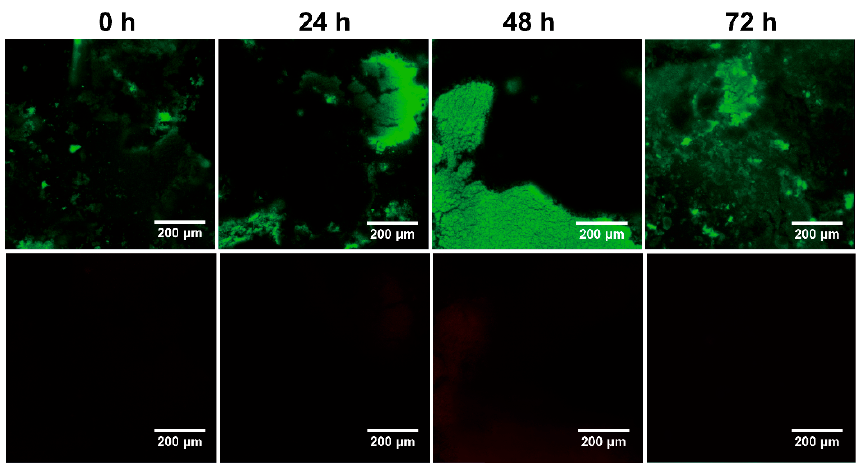
Figure 11. Fluorescence images of WLS samples were observed at 0 h, 24 h, 48 h and 72 h, respectively.